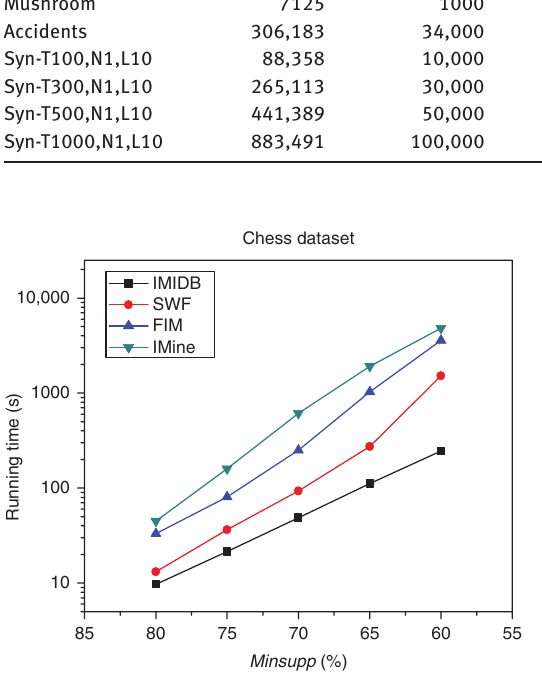
Figure 7: Running Time Comparison – Chess